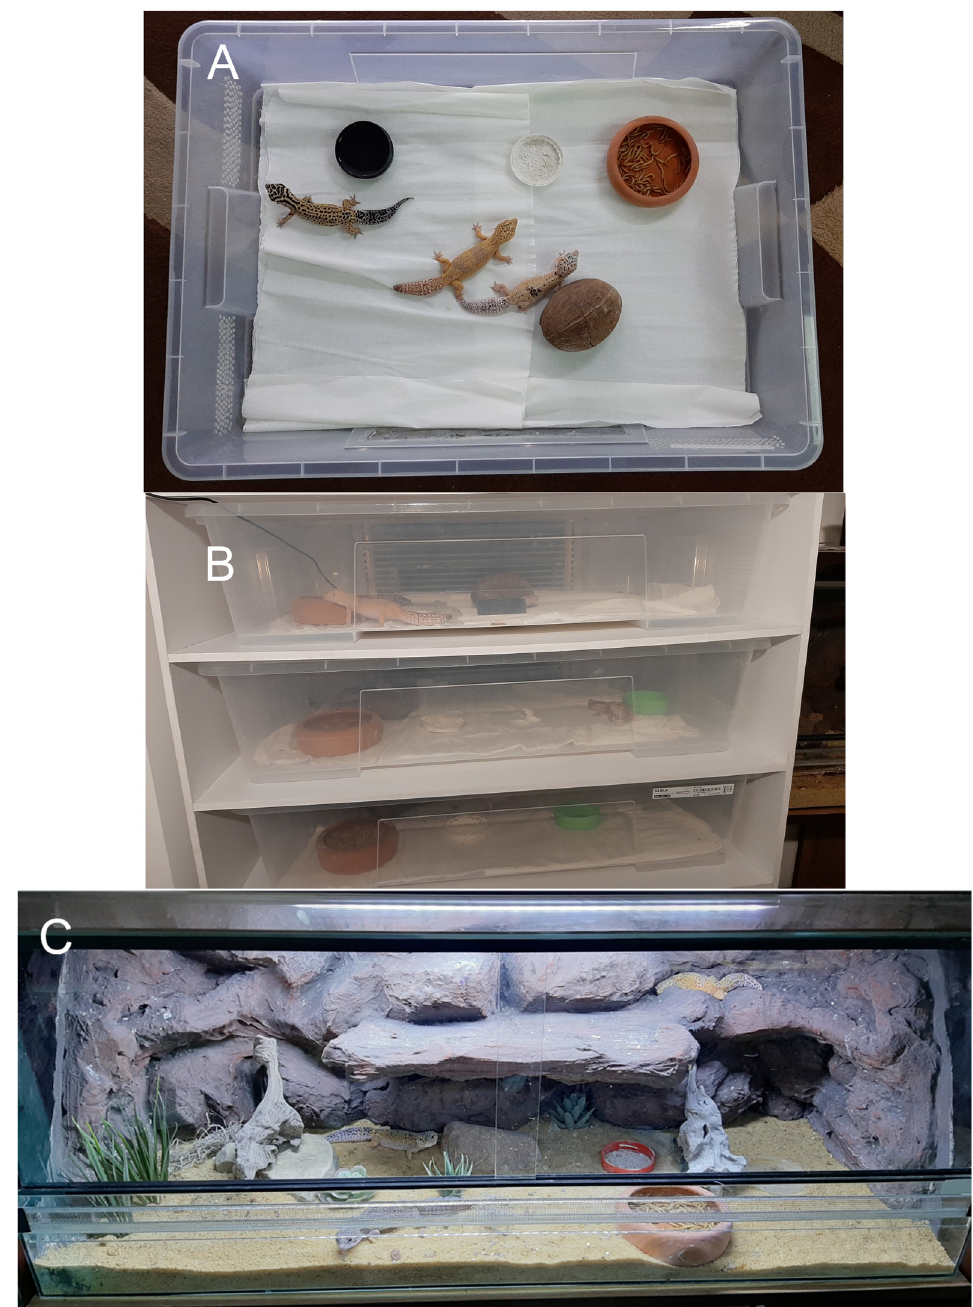
Figure 1. Captive environments used in the study. ( A , B ) rack system, ( C ) biotope terrarium. Each enclosure with reptiles was maintained at a 12 h day/night cycle, with lights on at 08:00 and off at 20:00. The animals were fed with crickets ( Gryllodes sigillatus ), mealworms ( Tenebrio molitor ), and superworms ( Zoophobas morio ) 3 times per week (feeder insects obtained from Bugstore, Krak ó w, Poland), with constant access to water and calcium. They were handled once a week during enclosure cleaning. The terrariums used in the study met the suggested absolute minimum requirements for reptiles set forth by Warwick et al. [2], while the containers in the rack system did not meet the requirements in terms of size; environmental conditions (temperature, humidity, food, access to water) were met, but lacked an adequate level of environmental